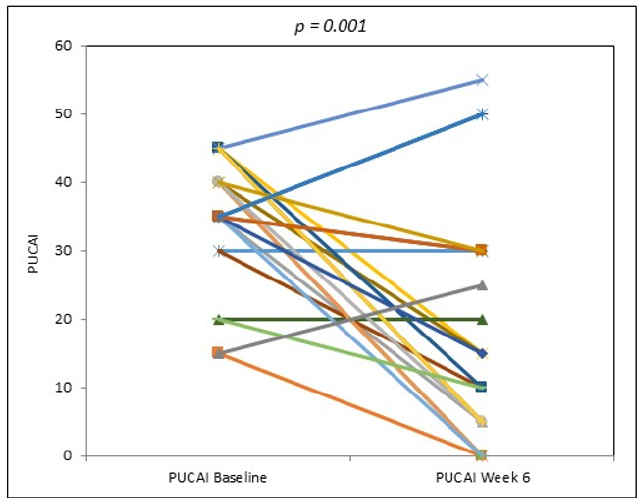
Figure 3. Change in PUCAI with UC exclusion diet between baseline and week 6, including all patients in a last-observation-carried-forward analysis.